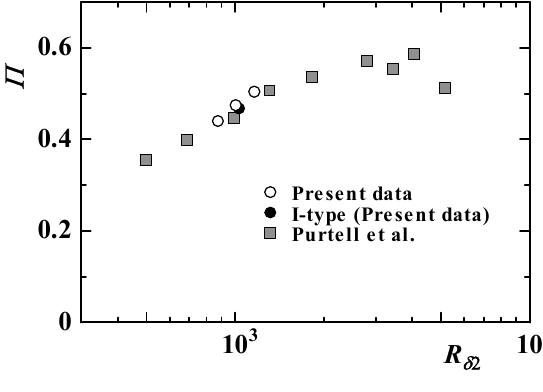
Fig. 15 Variation of wake parameters Π versus R